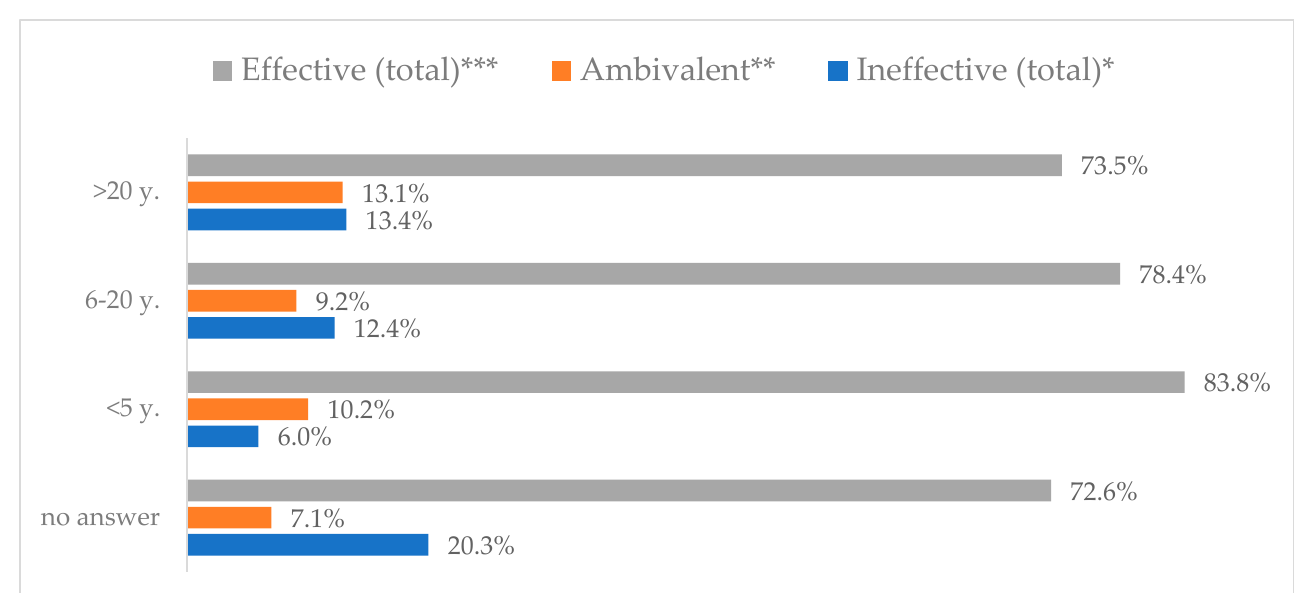
Figure 20. Avoiding contact with sick people to prevent influenza virus infection by seniority ( N = 905). *Sum of responses: completely ineffective, ineffective, rather ineffective; **Response: neither ineffective nor effective; ***Sum of responses: rather effective, effective, completely effective.